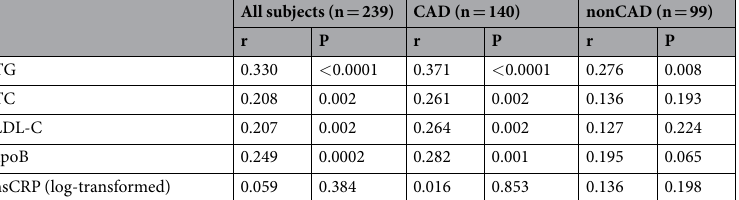
Table 3. Pearson’s correlation analyses between log-transformed plasma apoCIII and clinical and biochemical parameters. CAD indicates coronary artery disease; TG, triglyceride; TC, total cholesterol; LDL-C, low-density lipoprotein-cholesterol; apoB, apolipoprotein B; hsCRP, high-sensitivity C reactive protein.